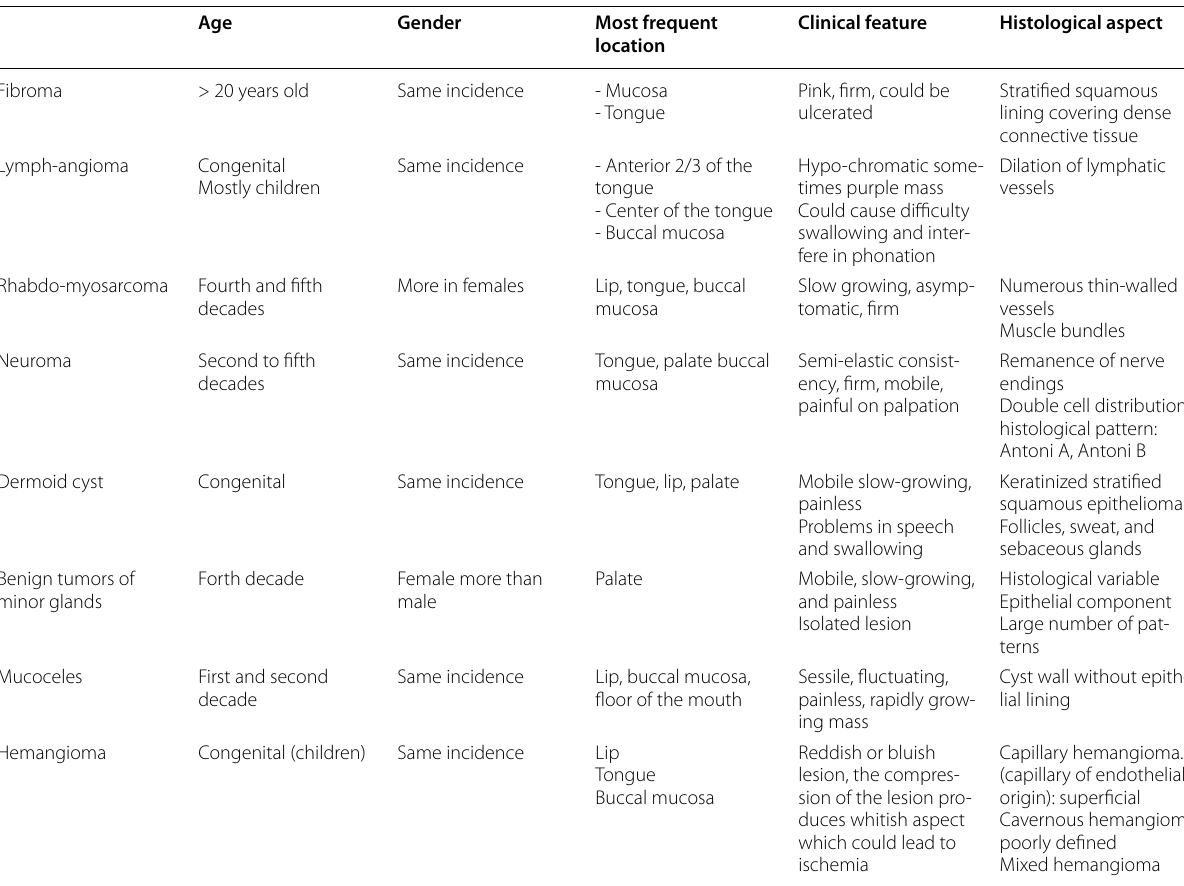
Table 1 Differential diagnosis of lipoma of the vestibular region in the oral cavity [1–5, 8] Age Gender Most frequent Clinical feature Histological location